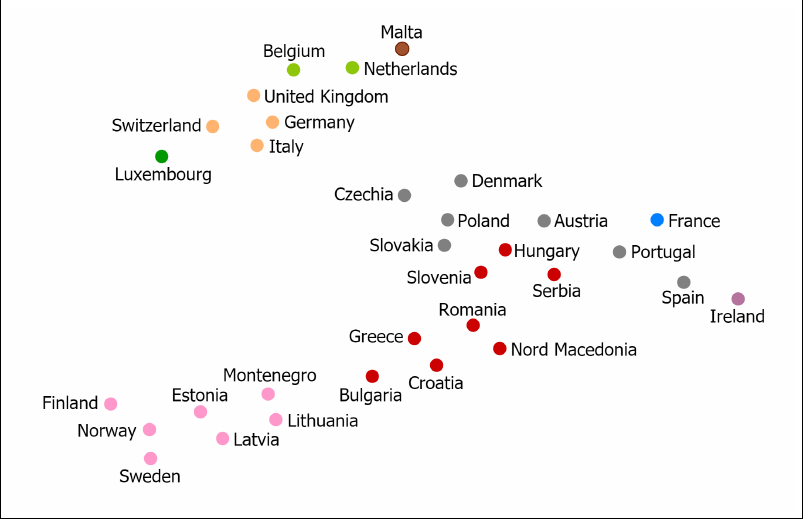
Figure 3. Visualization results of the analyzed data from 1 April to 5 May 2020, obtained using the t-SNE method. Countries labeled by the same color represent the same cluster obtained with SOM, which means a similar spread of COVID-19.